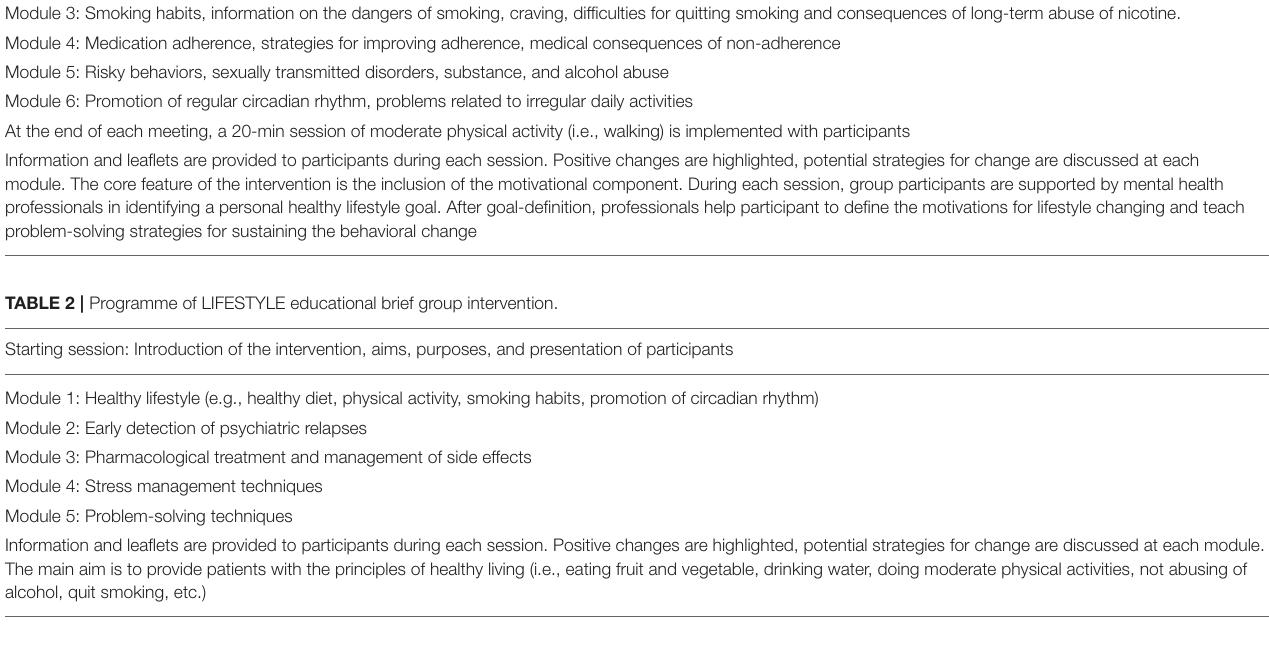
TABLE 1 | Programme of LIFESTYLE psychosocial group intervention. Starting session: Introduction of the intervention, aims, purposes, presentation of participants, and definition of personal healthy lifestyle goals Module 1: Diet, information on health food, principles, and benefits of healthy